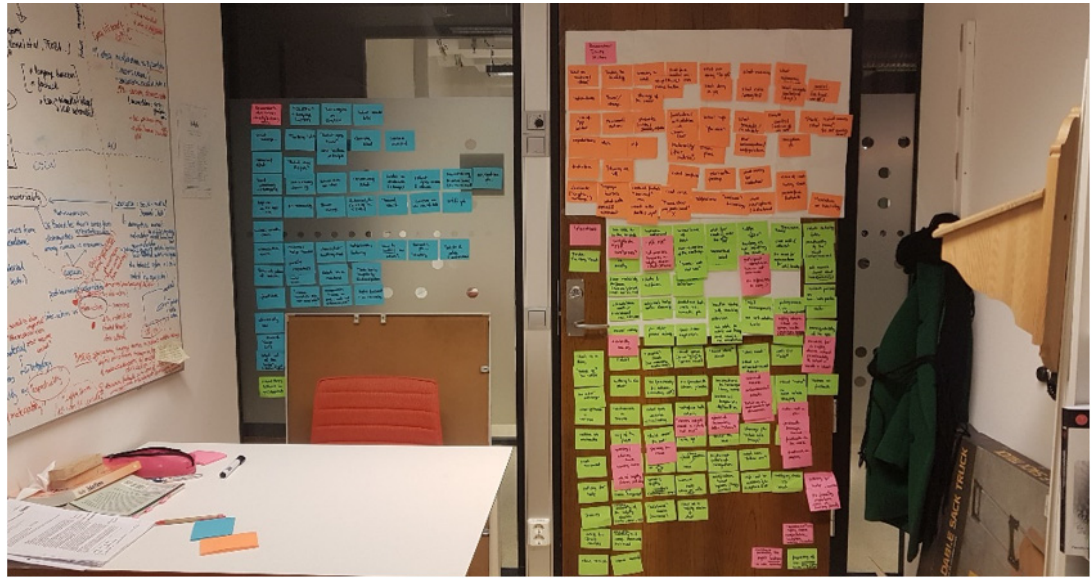
Figure 1. Photo from the data analysis—collating codes into sub ‐ categories.